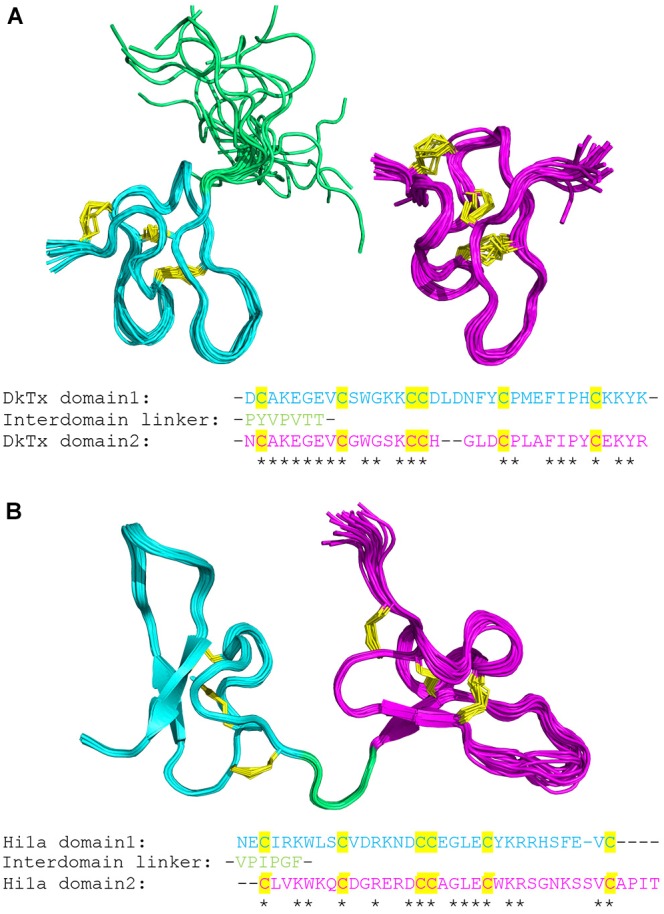
3D structure and domain alignment of ion-channel impairing SCREPs. (A) Solution structure of each individual domain of DkTx, with D1 (PDB-2N9Z) and D2 (PDB-2NAJ) in cyan and purple, respectively. The disulfide framework is highlighted in yellow, and the highly flexible linker region is shown in green. Below the structure is the primary sequence alignment of both domains, demonstrating the high level of homology between domains. (B) Solution structure of Hi1a (PDB-2N8F), highlighting each individual disulfide-rich domain connected by a more rigid peptide linker region. The aligned sequences of the individual domains are shown below.